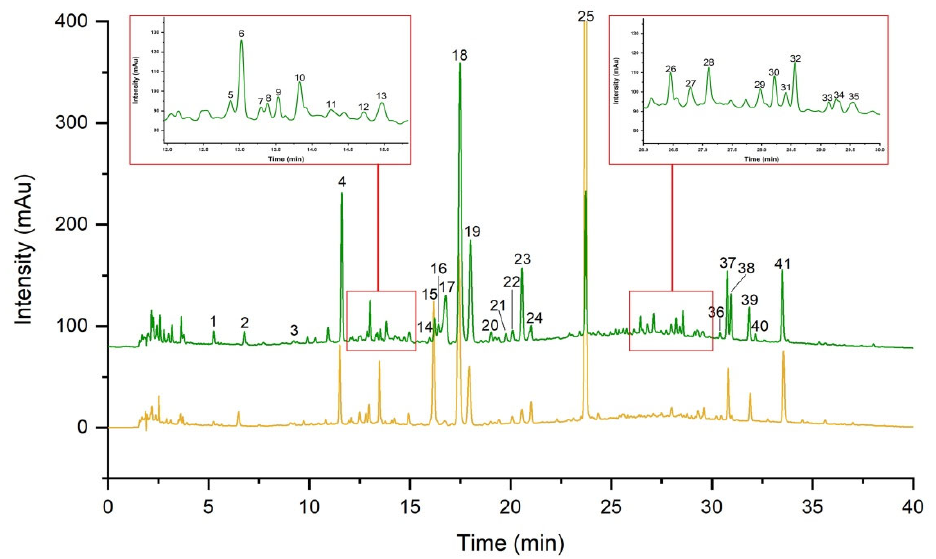
Figure 1. The representative fingerprints of cLJF sample (the green line) and wLJF sample (the yellow line). Numbers indicate a total of 41 peaks detected.